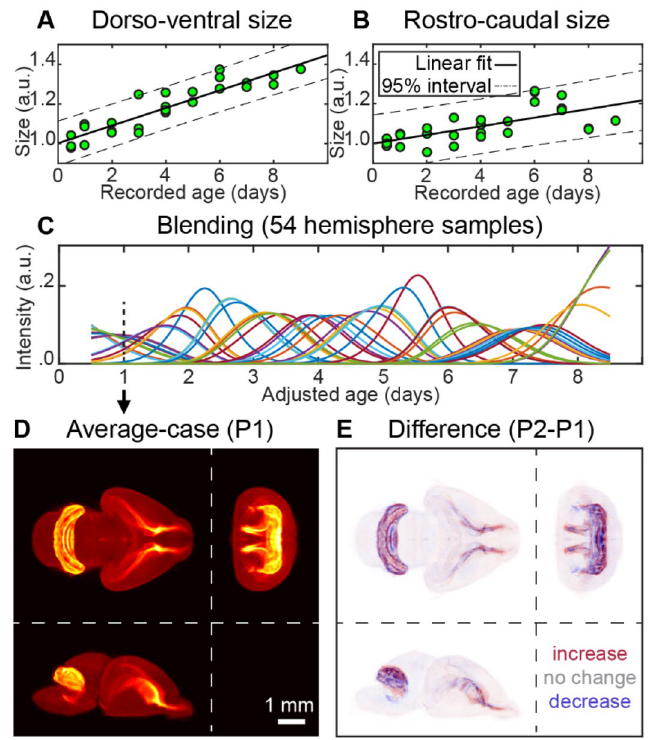
Figure 6. Using spatially and temporally registered brain samples to observe continuous brain development dynamics in 3D. ( A ) Dorsoventral and ( B ) rostrocaudal sizes of the brains normalized to the size at birth. Linear fit (solid line) and 95% confidence interval (dashed line). ( C ) Blending of 54 hemisphere samples. Colored lines show the weighting contributions of each hemisphere to every time point. Contribution (or intensity) is maximal at the sample’s adjusted age; it decays with a standard deviation of 1/2 of the sampling rate (1/2 day); total intensity adds up to one at every time point. ( D ) Weighted average image for P1 developing mouse brain in accordance with weighting curves ( C ). ( E ) Difference between weighted average images of P2 and P1 mouse brains. The increases and decreases in cell proliferation (EdU+ cell density) are color-coded by the intensities of red and blue